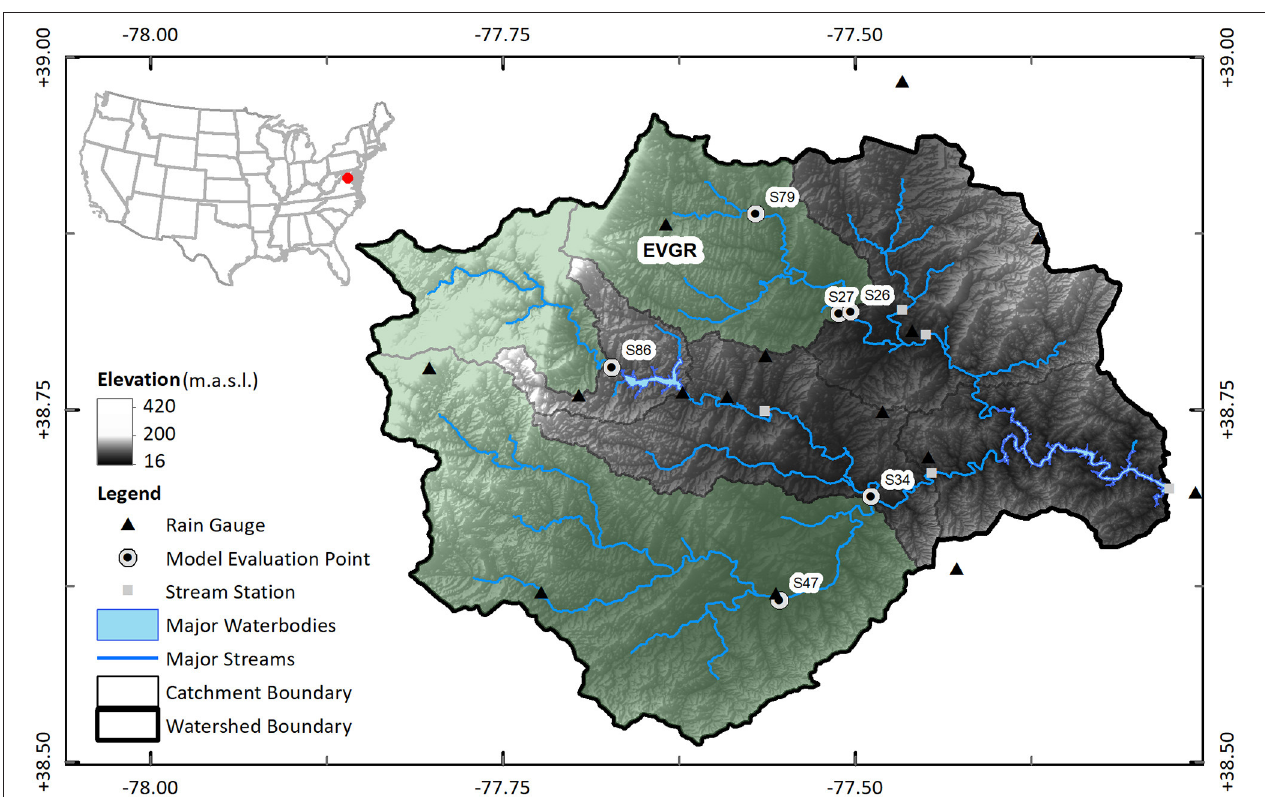
FIGURE 1 | Study area showing the Occoquan Watershed boundary, 7 catchments, topography, major streams, major waterbodies, locations of rain gauges, and stream monitoring stations, and the locations of model evaluation points (S47, S86, and S79 coincide with stream monitoring